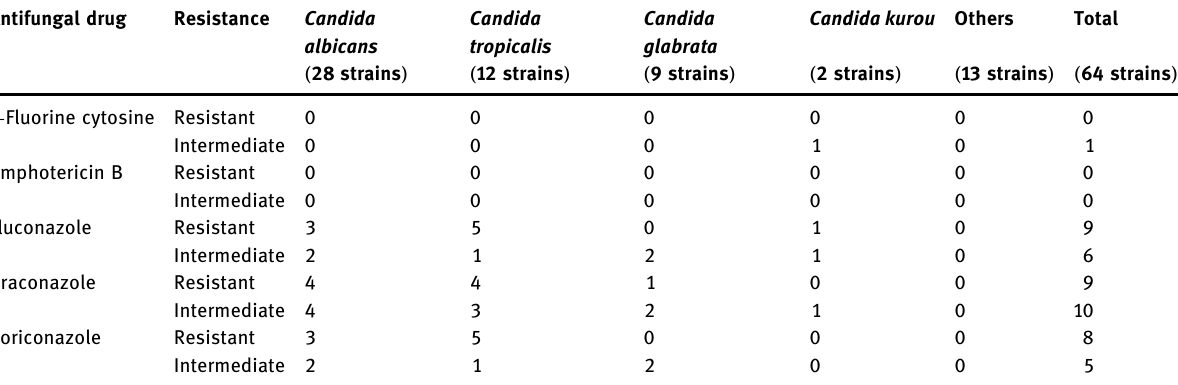
Table 1: Candida species identi fi ed on culture and drug resistance Antifungal